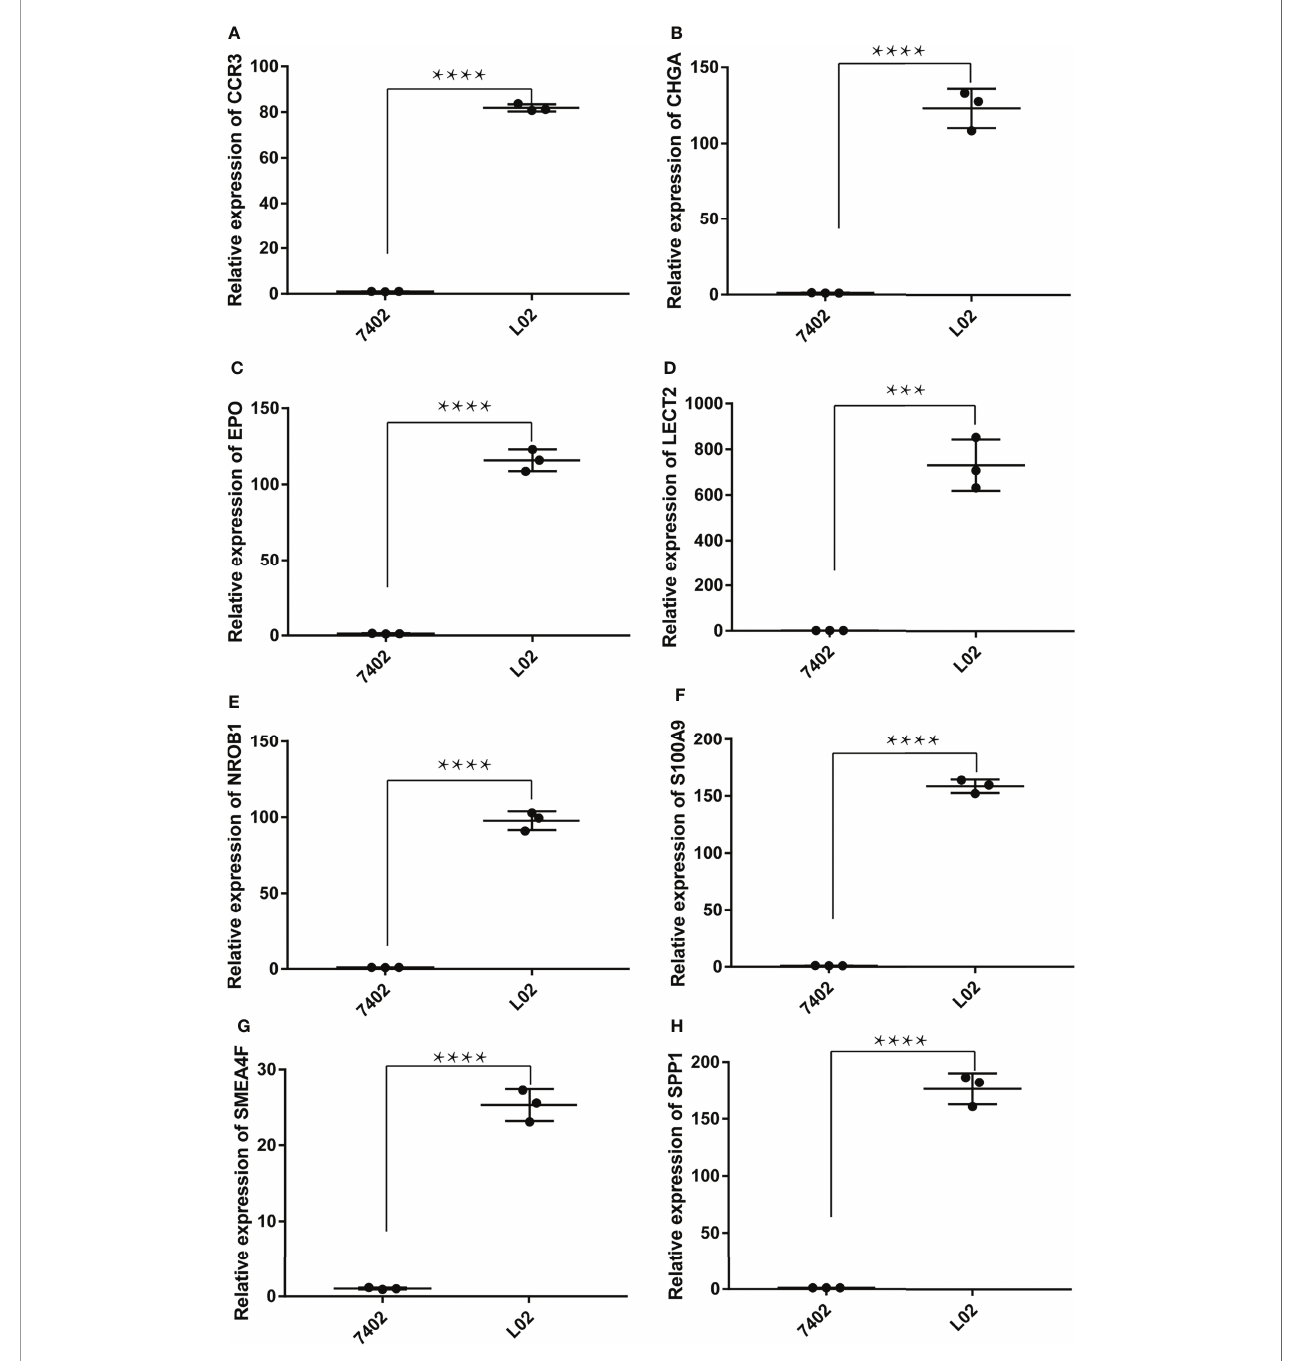
FIGURE 8 | The relative RNA expression level of LECT2, SEMA4F, EPO, CHGA, NR0B1, S100A9, CCR3, and SPP1. The RNA expression of CCR3 (A) , CHGA (B) , EPO (C) , LECT2 (D) , NR0B1 (E) , S100A9 (F) , SEMA4F (G) and SPP1 (H) were low expressed in human hepatoma cells compared with normal human hepatic epithelial cells (Unpaired t-test, *** P < 0.001, **** P <